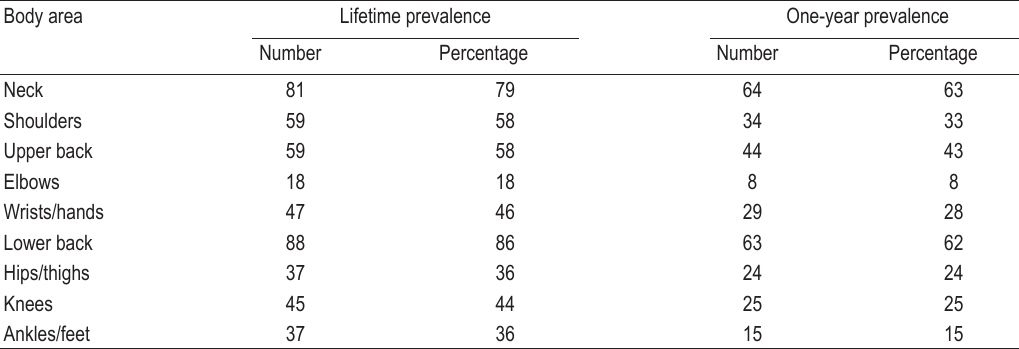
TABLE 2. Prevalence of WMSD for different body areas Body